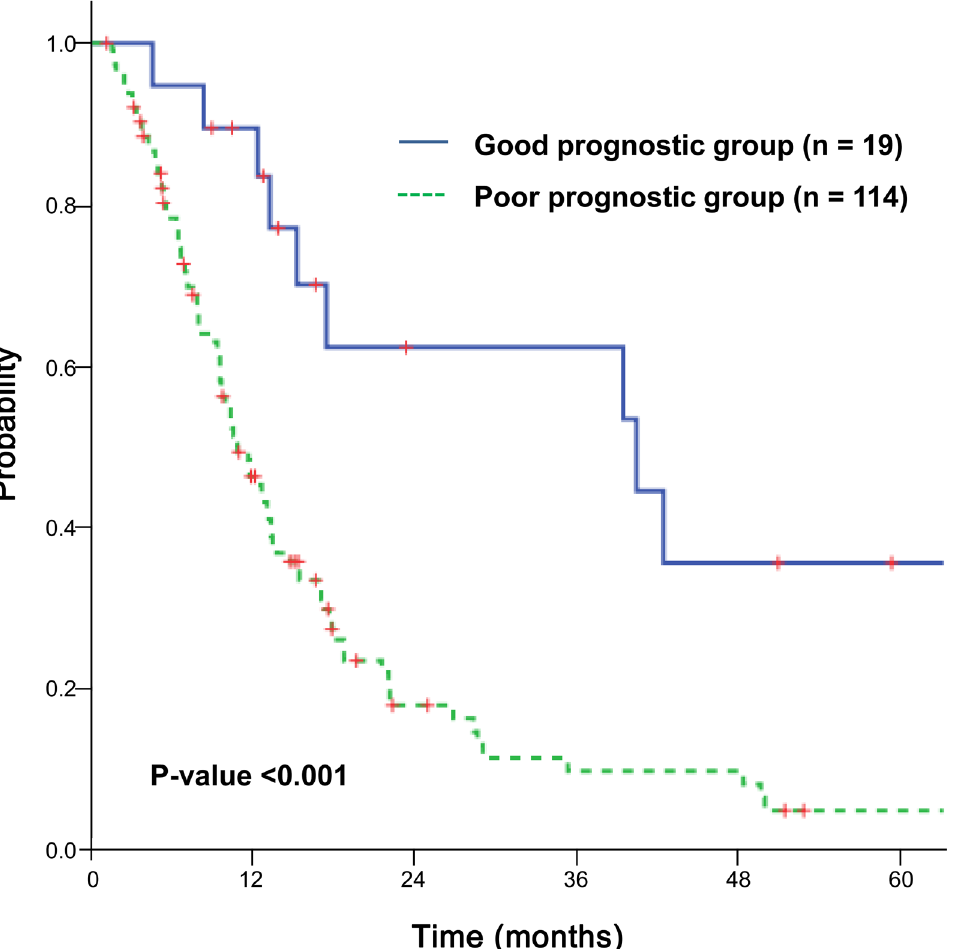
Fig 2. Overall survival curves according to the prognosis. Overall survival curves for the good prognostic group (n = 19) and poor prognostic group (n = 114) (p < 0.001).